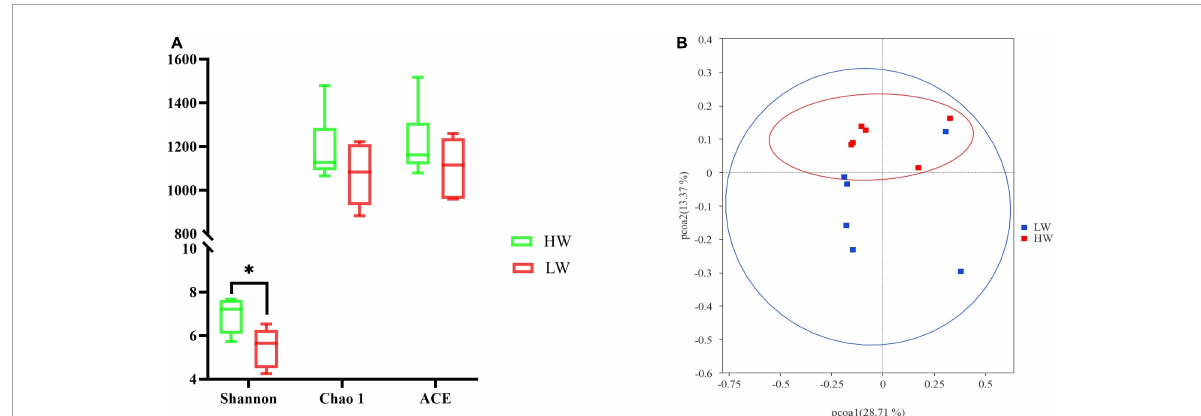
FIGURE2 The different gut microbiota communities between the HW and LW groups. (A) Bacterial alpha diversity is based on Shannon diversity, Chao1, and ACE index. ∗ Means the significant difference in statistics ( P < 0.05). Shannon diversity represents microbial community diversity, and Chao1 and ACE represent species richness. (B) Differences in Principal Coordinate Analysis (PCoA) of GM structures HW and LW groups. The red dots represent the samples of the HW group and the blue dots represent the samples of the LW group. The distance between the two points represents the difference in GM.